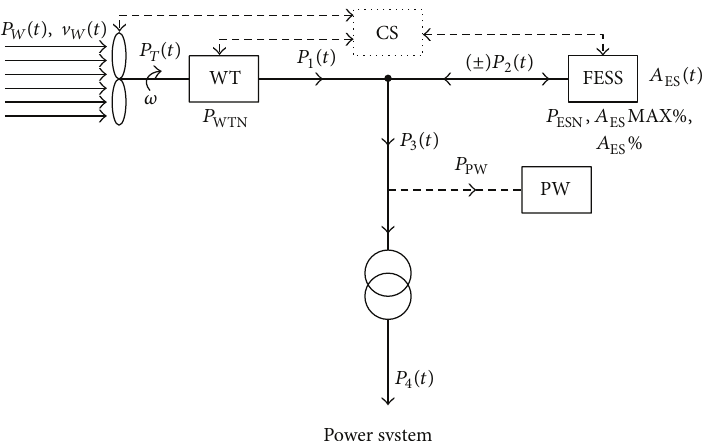
Figure 3: Construction diagram, principles of operation and power flow in the WT-FESS (WT—wind turbine, FESS—flywheel energy storage, CS—control system, 𝑃 𝑇 (𝑡) —mechanical power, 𝑃